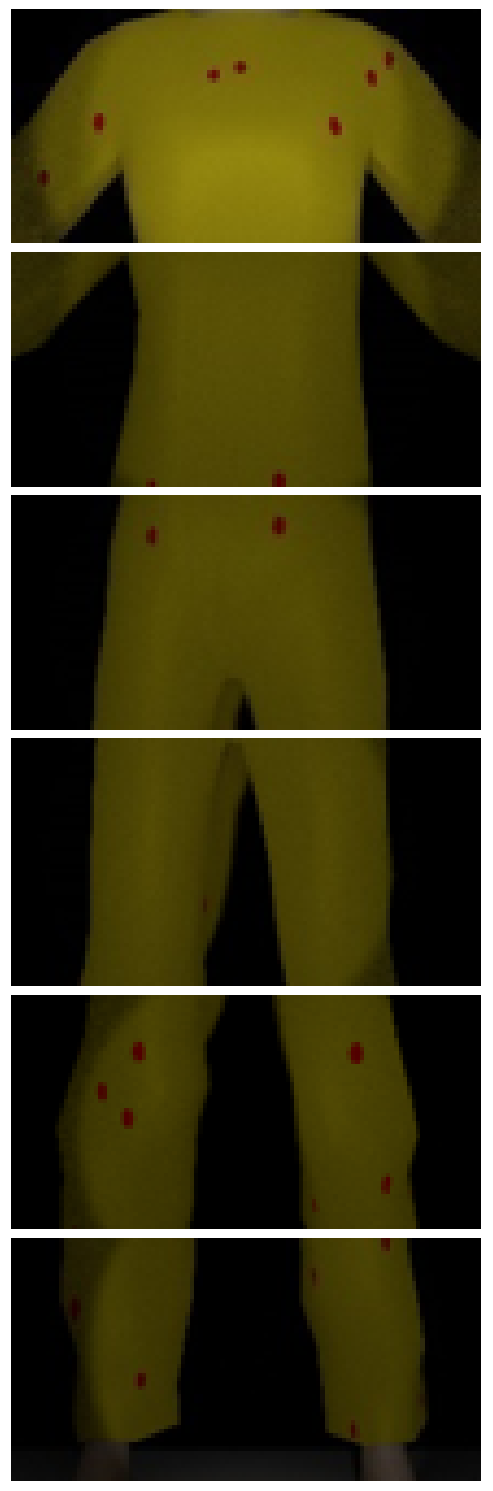
Figure 6. The full-body suit subdivided into six areas: chest, abdomen, pelvis, thighs, lower legs, and